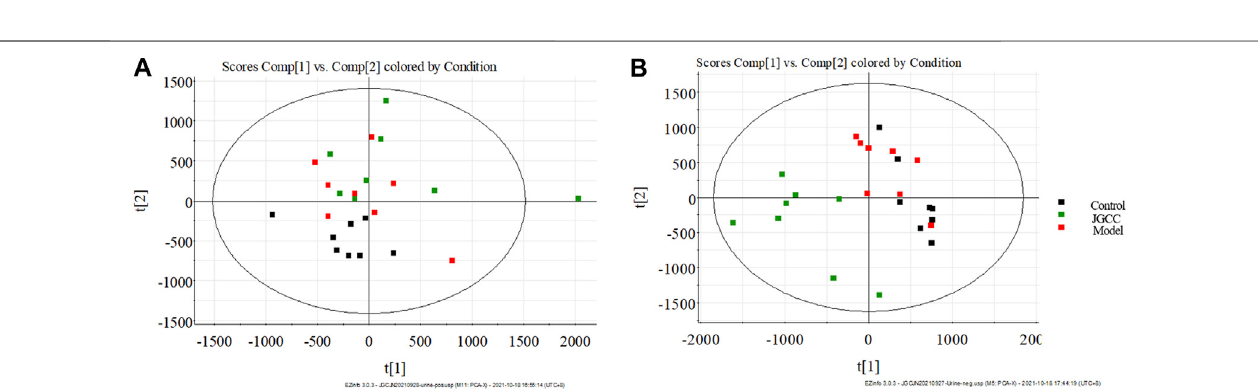
FIGURE 4 | PCA score plots of rat urine samples. (A) positive ion mode; (B) negative ion mode.